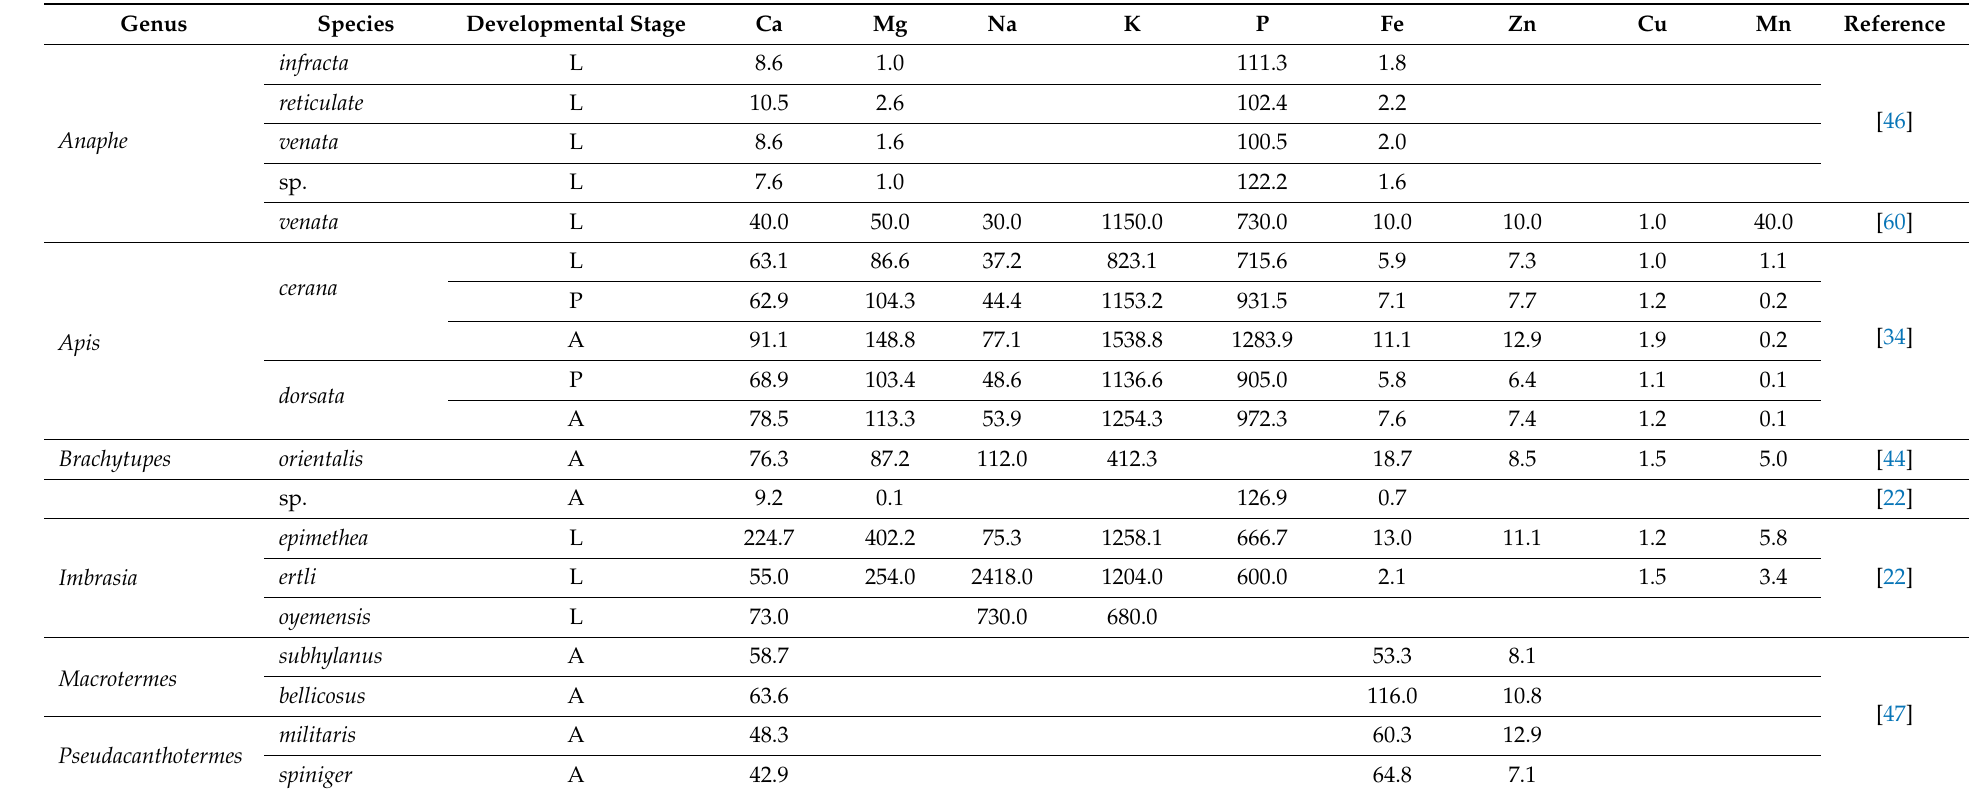
Table 5. Minerals content (mg/100g) of selected edible